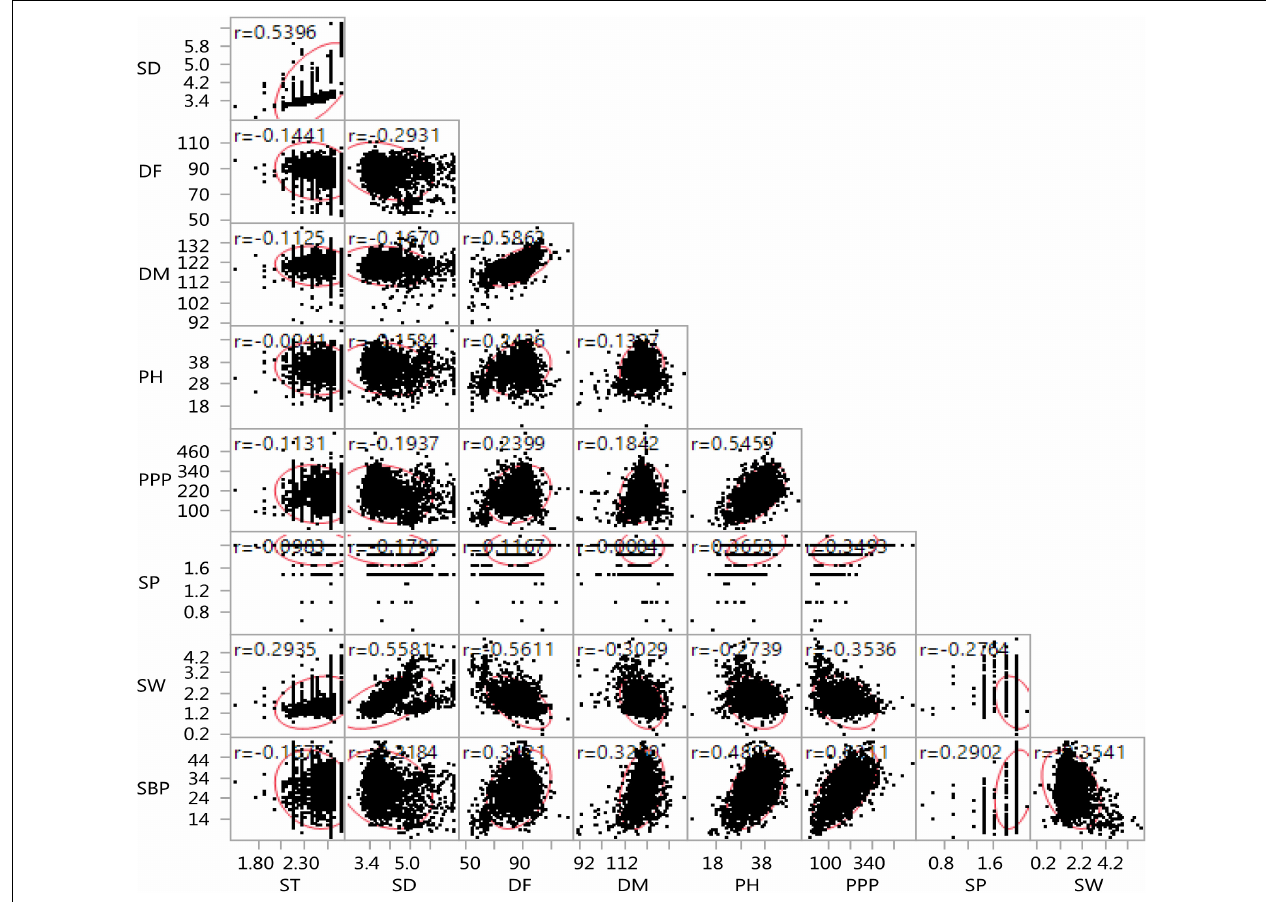
FIGURE 9 | Scatter plot matrix showing the correlation between nine agro-morphological traits of the entire lentil germplasm conserved in the Indian national genebank.